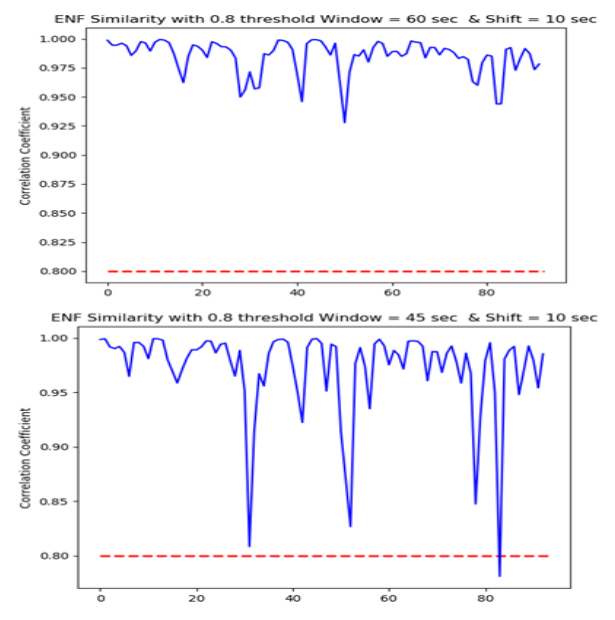
Figure 11. Comparing multiple window sizes and shift sizes for ENF